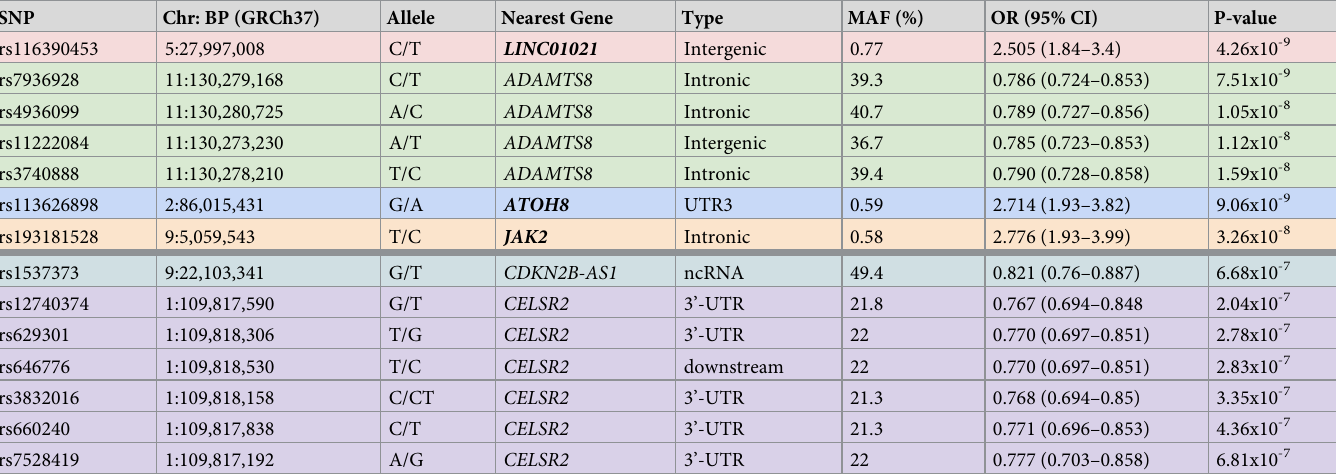
Table 2. Top SNPs associated with abdominal aortic aneurysm.